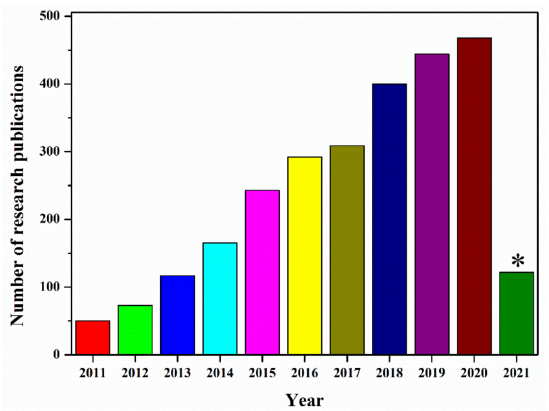
Figure 2. Number of research publications on biological synthesis of metallic NPs from last 10 years. Source: Scopus. * Number of publications reported as on 10 May